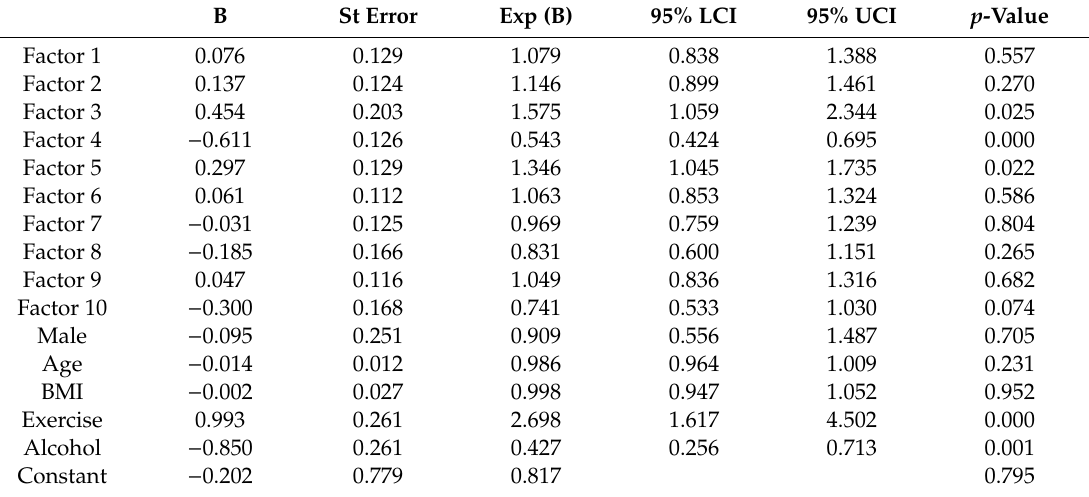
Table 3. Association of the presence of autoimmune disease with the Principal Components Dependent Variable: Absence of autoimmune disorder; Binary Logistic Regression. LCI: Lower Confidence Interval; UCI: Upper Confidence